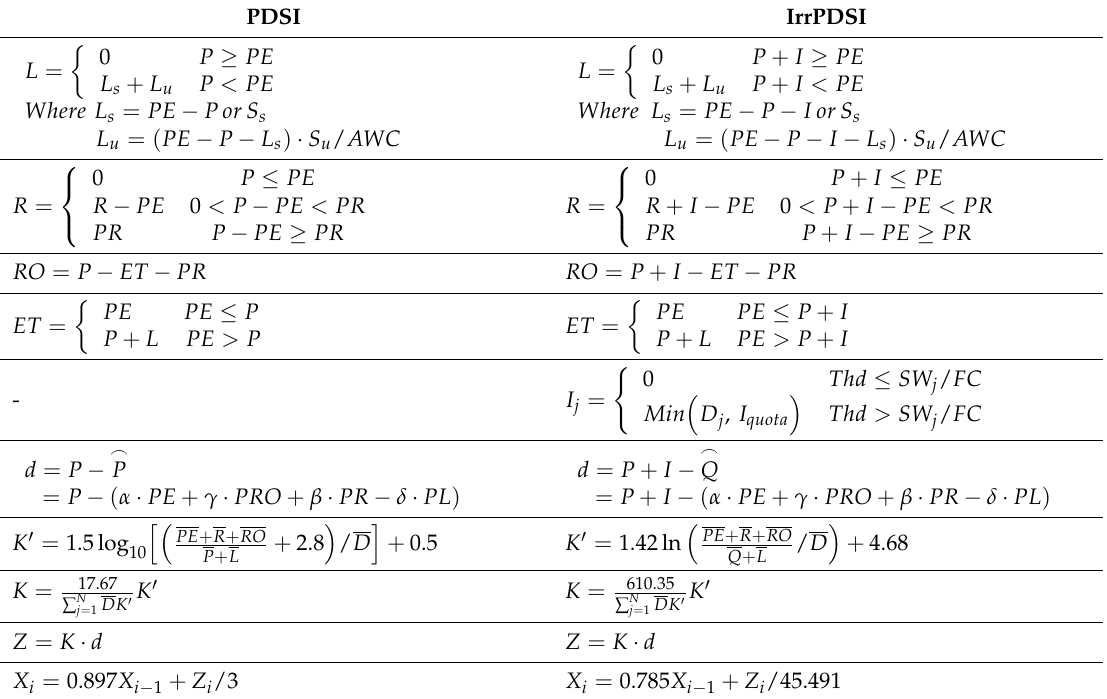
Table 3. Comparison of the computational formulas of the two indices.